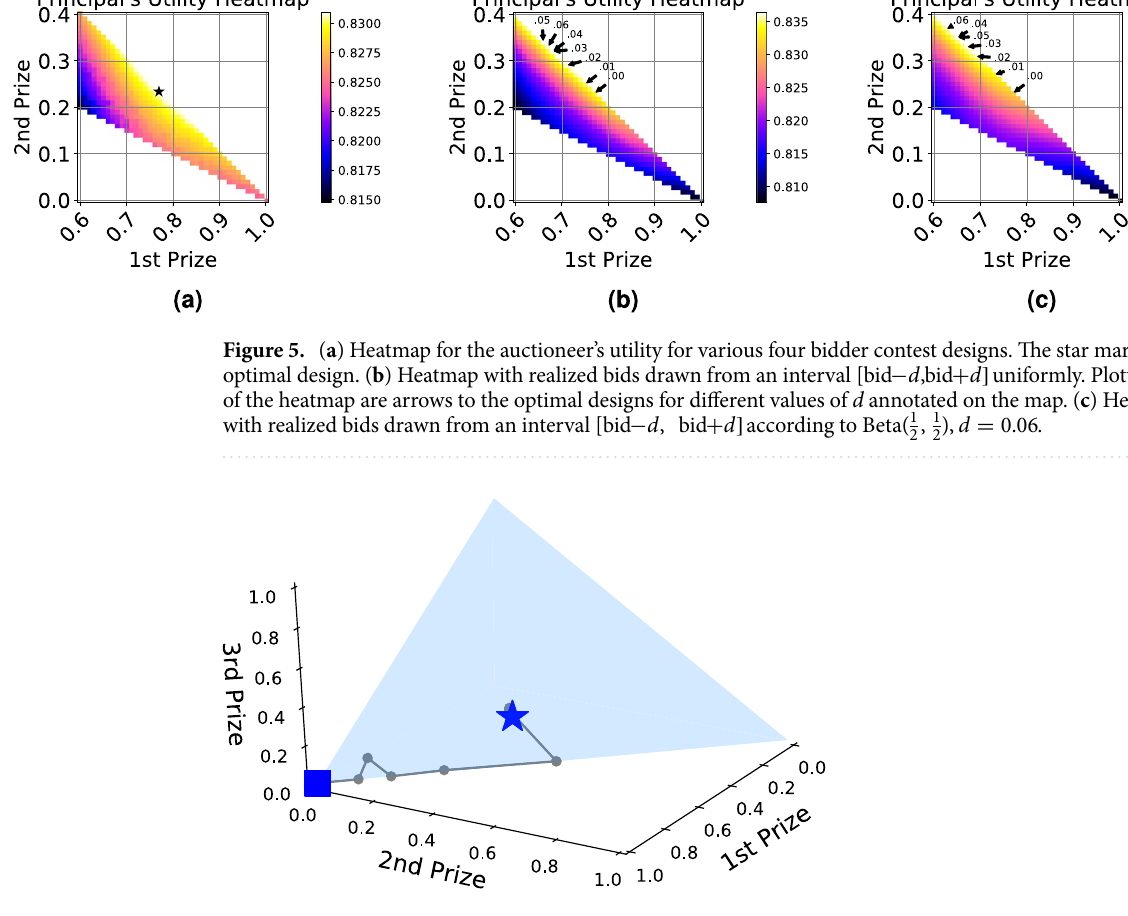
Figure 6. First three prizes of the optimized ten bidder contest plotted on top of a simplex for reference. Each point denotes the optimal design for a different noise level. The square marks zero noise with the trajectory ending at the star with realized bids drawn uniformly from bid ± 0.06